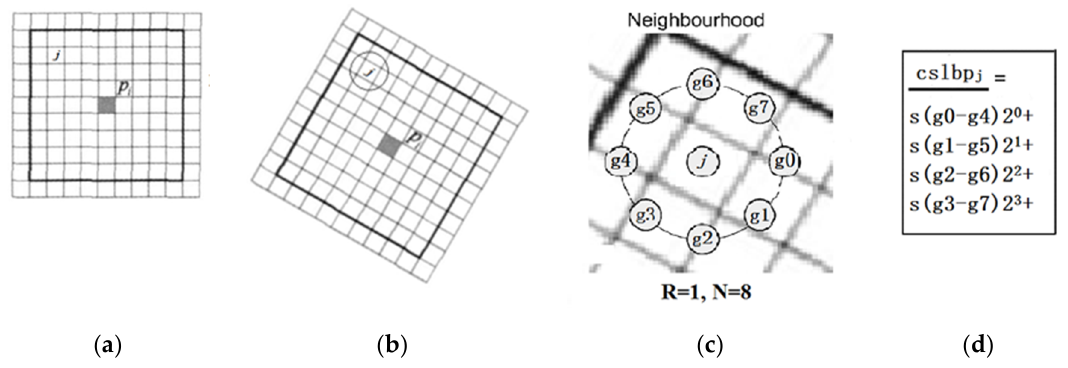
Figure 1. Steps to compute center-symmetric local binary pattern (CS-LBP) features. ( a ) Area to compute the CS-LBP features centered around the keypoint; ( b ) the area after rotation; ( c ) CS-LBP feature for a neighborhood of 8 pixels of j , when R = 1 and N = 8; ( d ) binary pattern for CS-LBP feature of j